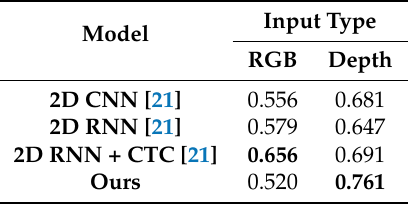
Table 5. Comparison with competitors on the NVGestures dataset [21]. The overall accuracy for the RGB and the depth data type is